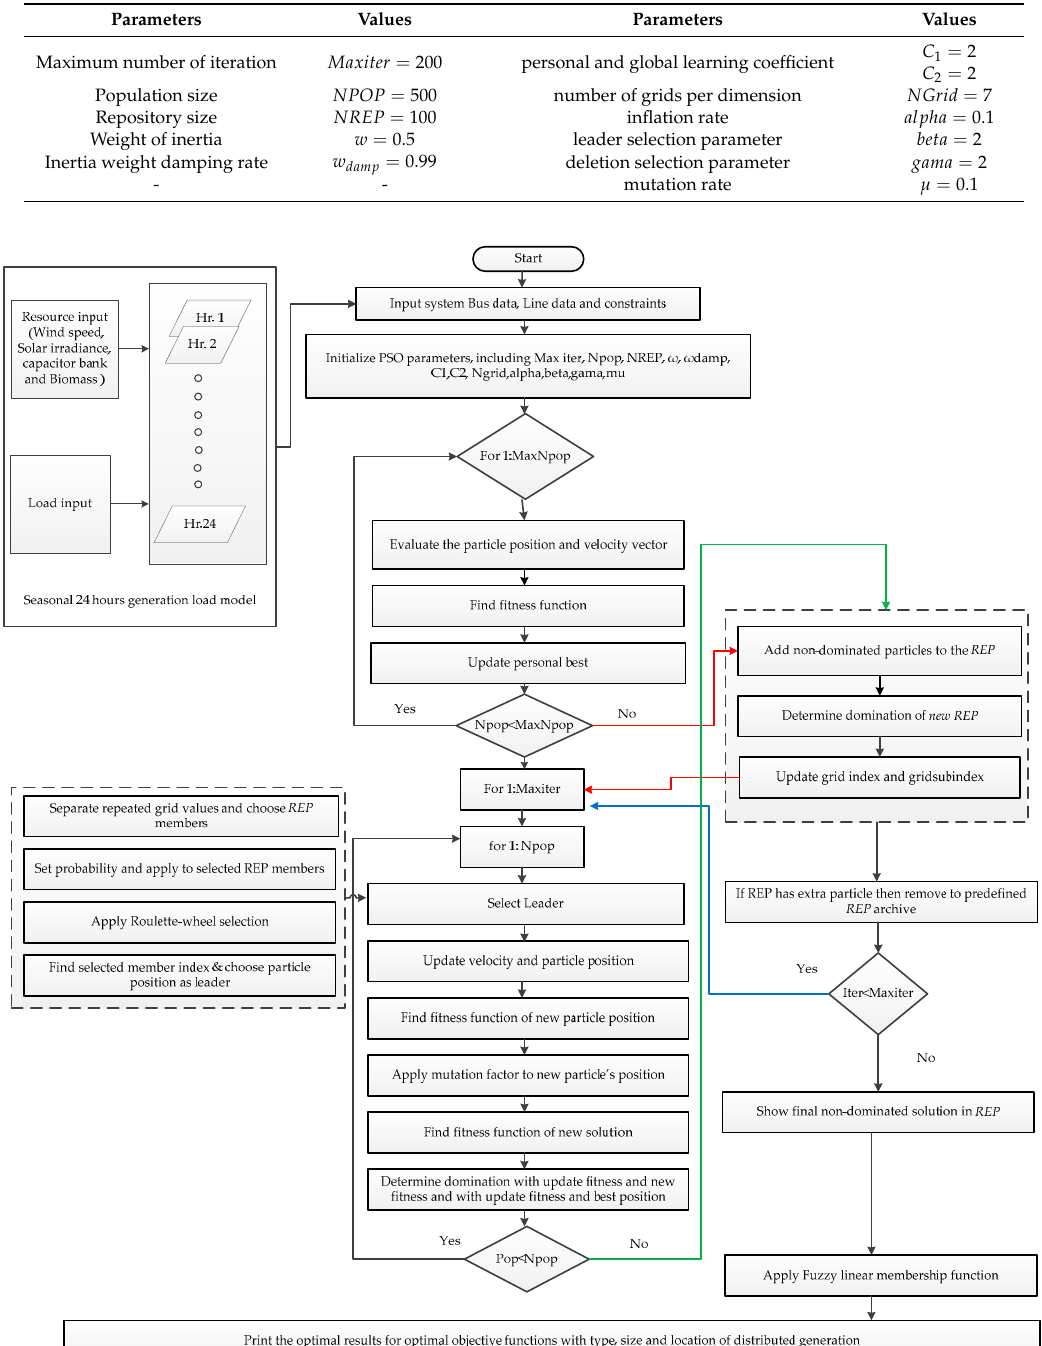
Figure 2. Flow chart for optimal DG configuration using proposed method.